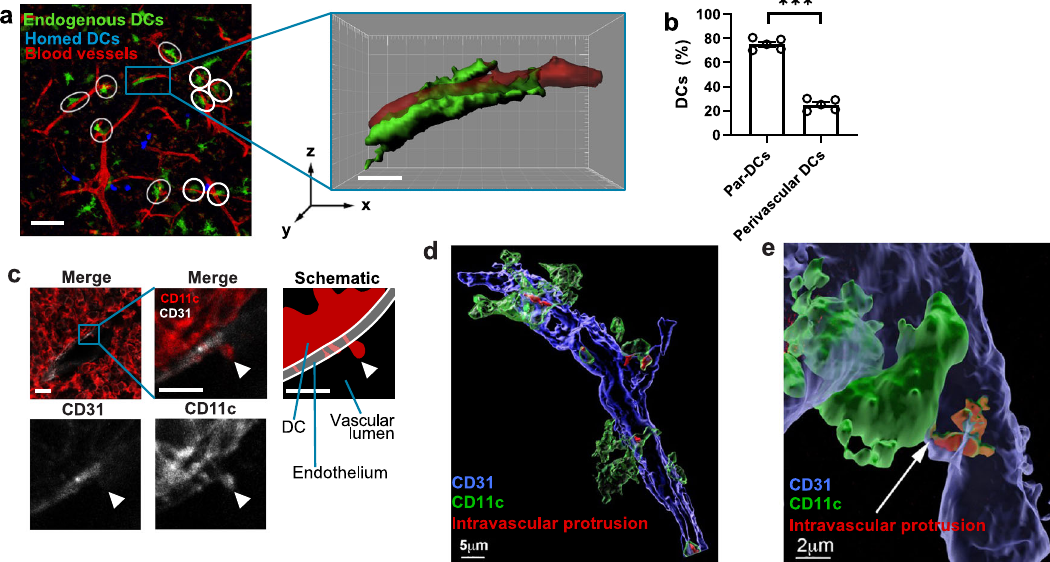
Fig. 3 Identi fi cation of thymic TE-DCs. a Representative MP-IVM micrograph of a thymus graft in a CD11c-YFP BM chimeric mouse (left panel). In all, 2 hours after adoptive transfer of labeled DCs, both homed DCs (blue) and endogenous DCs (green) are readily detectable in proximity to microvessels, which were visualized after injection of TRITC-labeled 2 MDa dextran (red). Circles identify typical DCs that are closely associated with microvessels. The box highlights one perivascular cell, which is shown in the right panel after the digital surface rendering of the DC and microvascular lumen (Supplementary Movie 3). Scale bars represent 50 μ m (left panel) and 10 μ m (middle panel), respectively. b The frequency of parenchymal and perivascular DCs in transplanted thymi was evaluated in confocal micrographs. Cells were considered as perivascular when the shortest distance between the margin of the cell and the lumen of the blood vessel was <1 μ m. n = 5; *** P = 0.0003 (Student ’ s two-tailed, paired t test). c Confocal micrograph of a frozen thymic (ET) section showing CD11c + DCs (red) extending protrusions through CD31 + vascular endothelium (white). The upper panels show merged two-color overlays at low (left) and high magni fi cation (middle) and a schematic illustration of the latter (right). The lower panels show single channels for CD31 (left) and CD11c staining (right) of the same high-power fi eld. Scale bars re fl ect 10 μ m. d 3D reconstruction and surface rendering from a confocal z-stack of a frozen thymic section similar to that described in c , showing the vasculature in blue (CD31 staining), perivascular CD11c + DCs in green (GFP signal), and their intravascular protrusions pseudocolored in red. To facilitate visualization of the transendothelial protrusions, only the perivascular GFP + DCs are shown in the analysis. (Supplementary Movie 4). e Zoomed-in detail showing the constriction of the cell body of a perivascular GFP + DC presumably protruding across the endothelial junction (arrow). DCs dendritic cells, Par-DCs parenchymal dendritic cells. See also Supplementary Movie